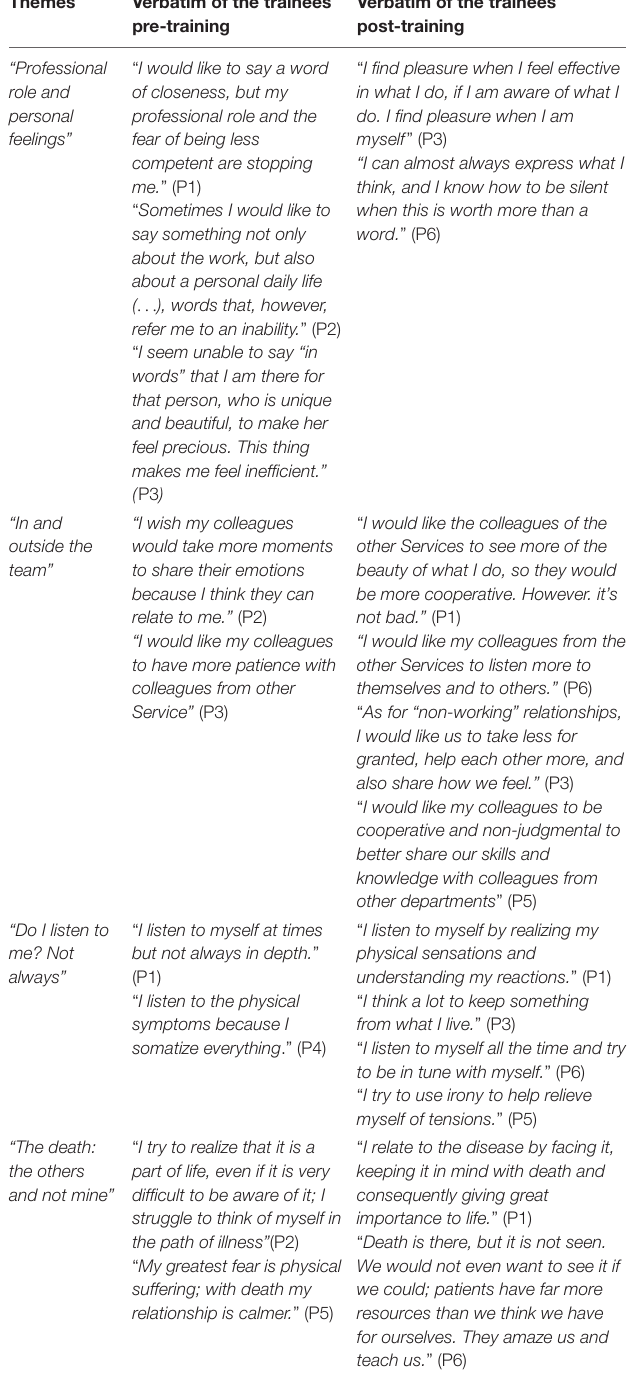
TABLE 3 | Major Theme Exemplars pre-test and